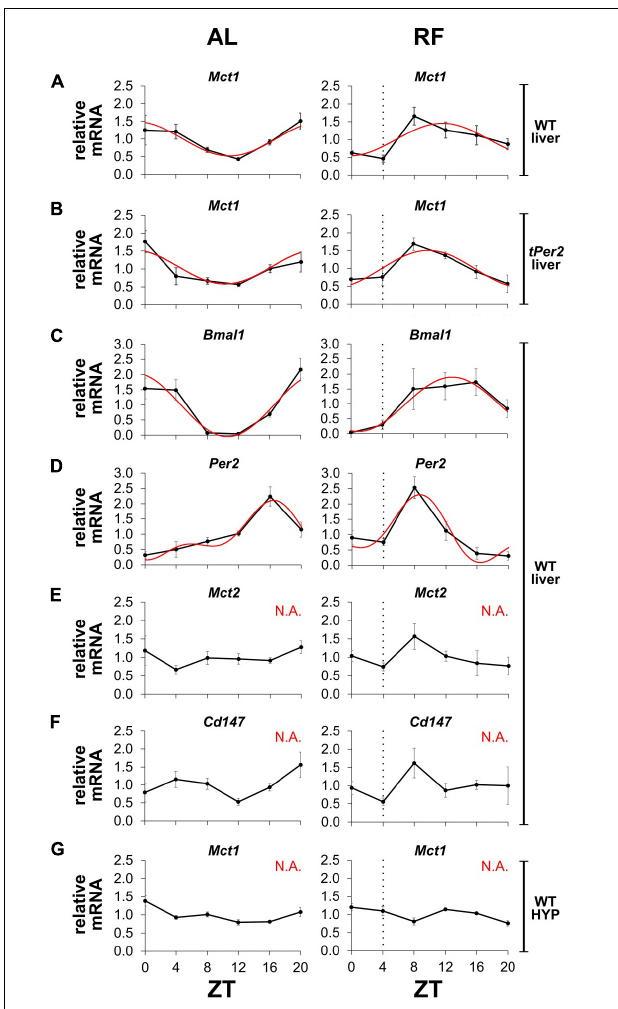
FIGURE 5 | Mct1 expression adapts to feeding time. mRNA expression under ad libitum (AL, left panels) and restricted feeding (RF, right panels) conditions. The black hatched vertical line indicates feeding time. (A) Mct1 expression in liver of wild-type (WT) mice. (B) Mct1 expression in liver of total Per2 knock-out ( tPer2 ) animals. (C) Bmal1 , (D) Per2 , (E) Mct2 , and (F) Cd147 , expression in liver of WT mice. (G) Mct1 expression in the hypothalamus (HYP) of WT animals. Tissue at ZT4 was harvested just before feeding. Red lines represent fitted curves, calculated with CircWave 1.4 (R. Hut). Based on the fits, Mct1 in WT animals peaks at ZT 22.8, whereas in total Per2 KO animals it peaks at 22.3. Bmal1 peaks at 22.6 and 13.0, respectively, and Per2 at 16.4 and 8.7. Under RF, the expression of Mct1 in WT animals is advanced 11.11 h (AL: p = 4.2 × 10 − 3 , R 2 = 0.517; RF: p = 1.2 × 10 − 2 , R 2 = 0.443), while in total Per2 KO animals the advance is 12.49 h (AL: p = 4.7 × 10 − 3 , R 2 = 0.510; RF: p = 1.1 × 10 − 3 , R 2 = 0.598). Bmal1 is advanced 9.65 h (AL: p = 4.9 × 10 − 5 , R 2 = 0.734; RF: p = 3.6 × 10 − 3 , R 2 = 0.527), whereas Per2 advances 7.73 h (AL: p = 2.2 × 10 − 4 , R 2 = 0.794; RF: p = 1.6 × 10 − 3 , R 2 = 0.717). “N.A.” indicates that a fit was not possible (alpha < 0.05). Error bars represent the standard error of